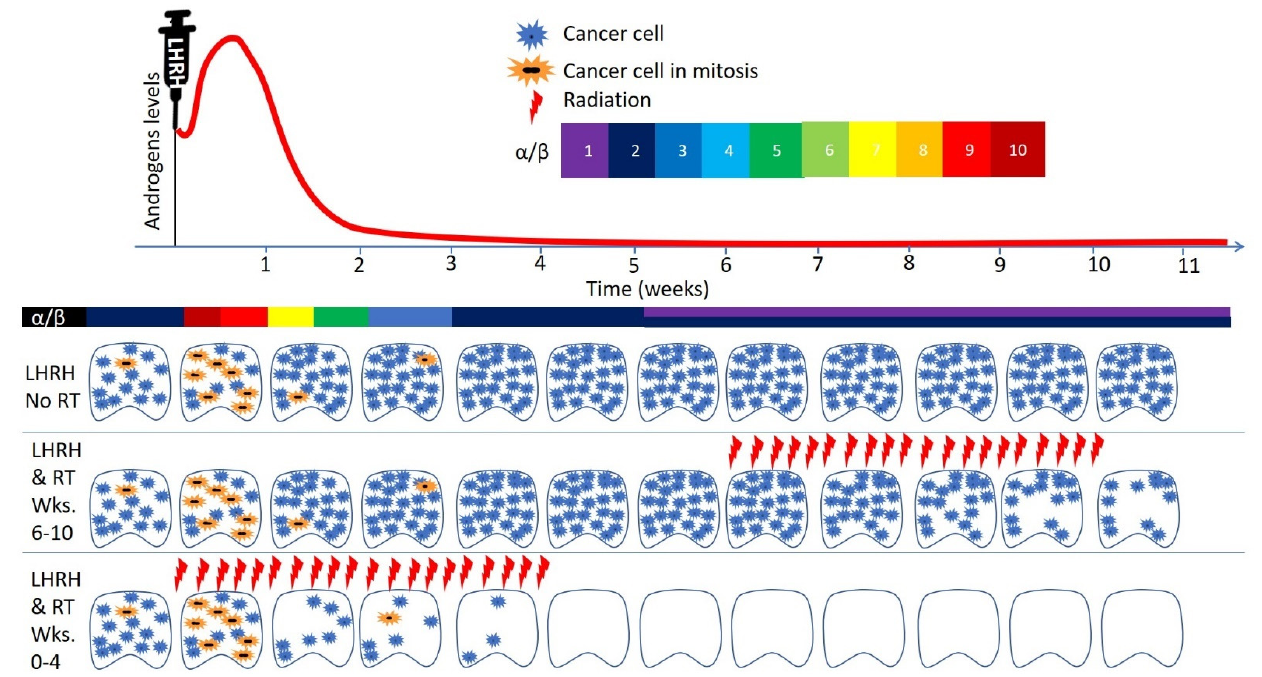
Figure 3. Prostate cancer treatment with luteinizing hormone-releasing hormone (LHRH), without or with radiation. Long-acting, continuously released LHRH initially results in increased production of androgens in the testicles, and secretion of testosterone to the systemic circulation for few days. During the first 7–10 days after LHRH initiation, blood androgen levels increase in what is known as androgen flare. Androgen flare most likely results in a change in the alpha/beta ratio of the prostate, and drives it to high values, most likely of 10 Gy or more. After androgen flare, the alpha/beta ratio drops until a level of approximately 1.5 Gy is reached. During androgen flare, prostate tumor cell division increases. With maintenance of continuous LHRH therapy, androgen deprivation ensues and results in prostate cancer cells becoming less metabolically active, and tumor cell division decreases significantly (top panel, prostate cancer treated with LHRH no RT). When neoadjuvant LHRH is provided, and radiation therapy is delivered 6–10 weeks after LHRH initiation, the number of dividing prostate cancer cells at time of radiation is low, necessitating radiation dose escalation to achieve tumor control (LHRH and RT weeks 6–10), as in RTOG 9413. This is in contrast to providing radiation therapy during androgen flare, when more prostate cancer cells progress to mitosis, priming them to cell kill by radiation, as in EORTC 22863 and RTOG 85–31 (LHRH and RT weeks